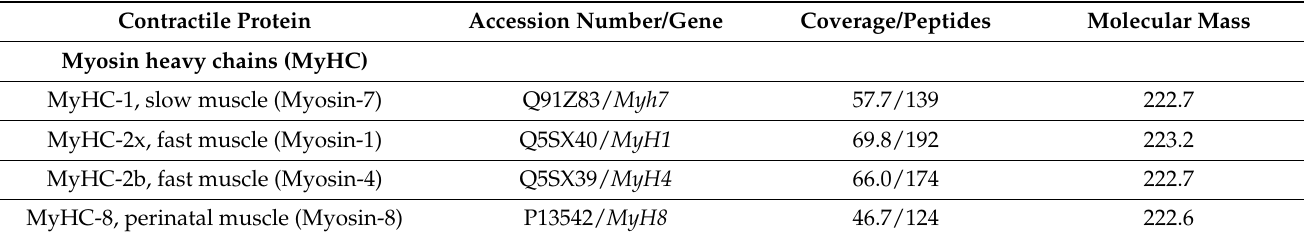
Table 1. Proteomic profiling of key components involved in the contraction–relaxation cycle of mouse diaphragm muscle